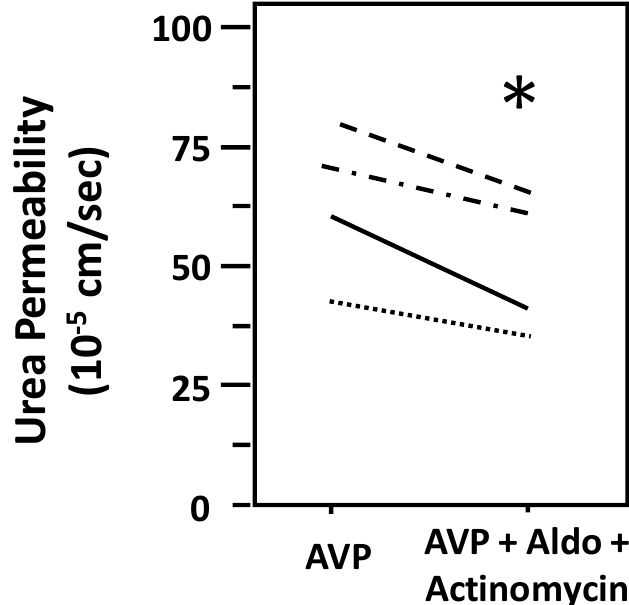
Figure 4. Aldosterone-attenuated urea permeability in male rat terminal IMCDs was not reversed by inhibition of gene transcription with actinomycin. Terminal IMCDs were perfused with 50 pM vasopressin (AVP), then treated with 1 µ M actinomycin for 30 min before adding 500 nM aldosterone (Aldo) for 30 min. Each line represents a separate IMCD from a different rat. * P <0.05 AVP control vs. AVP with Aldo plus actinomycin, N = 4 rats/condition.